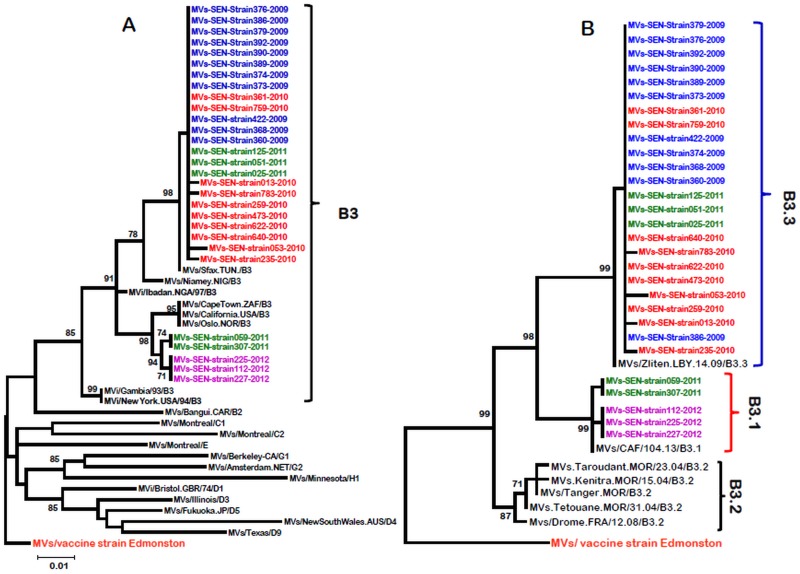
Phylogenetic analysis of strains from Senegal.Phylogenetic analyses based on the 526 nucleotides of the N gene C-terminus variable fragment obtained from 29 measles confirmed cases from Senegal between 2009 and 2012. Trees were prepared using Mega 5 version software and the neighbor-joining method with 1000 bootstrap replicates, and only bootstrap values over 70 are shown. Sequences from Senegal MeV strains are compared with the WHO reference sequences that are recommended for genotype identification (3A) and with the sequences of different B3 genotype subtypes retrieved on GenBank (3B). Senegalese MeV strains are highlighted in different colors.